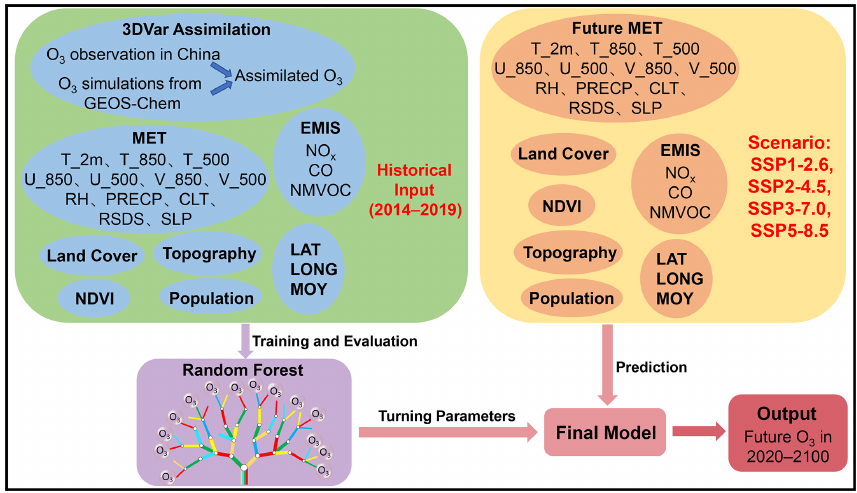
Figure 1. The structure and specific schematics for predicting future O 3 concentrations under four scenarios based on the machine learning (ML) method. MET: meteorology; EMIS: emissions; LAT: latitude; LONG: longitude; MOY: month of the year (see other definitions in Table